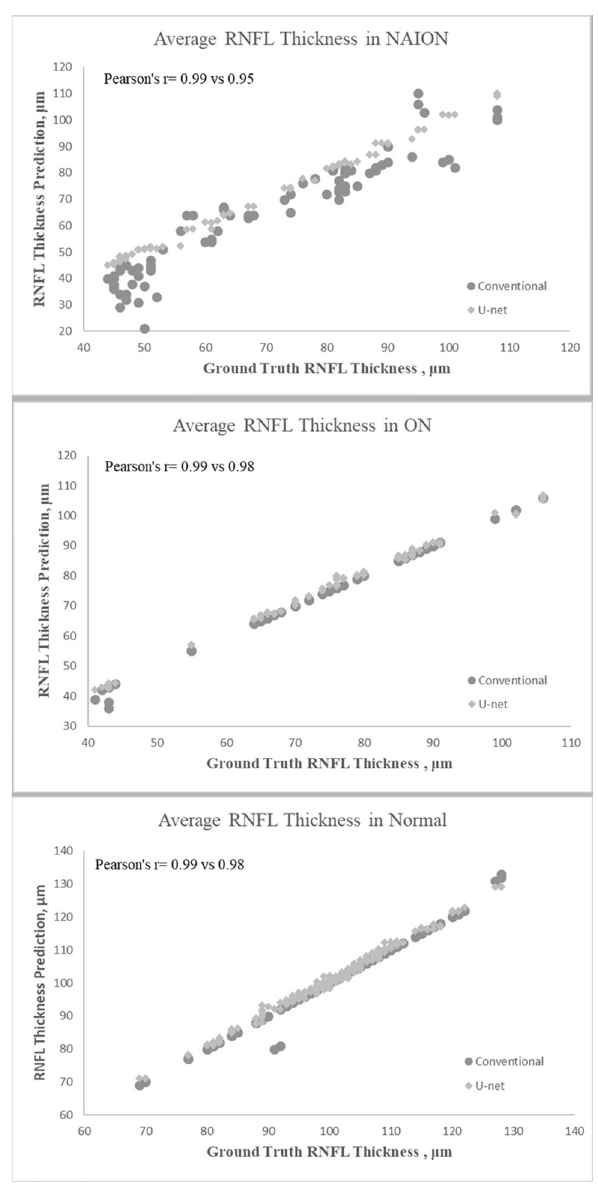
Figure 1. Line graphs showing correlation between average retinal nerve fiber layer (RNFL) thickness estimated by our U-Net and ground-truth in three study groups. ( A ) In anterior ischemic optic neuropathy (AION), ( B ) in optic neuritis (ON) and ( C ) in normal